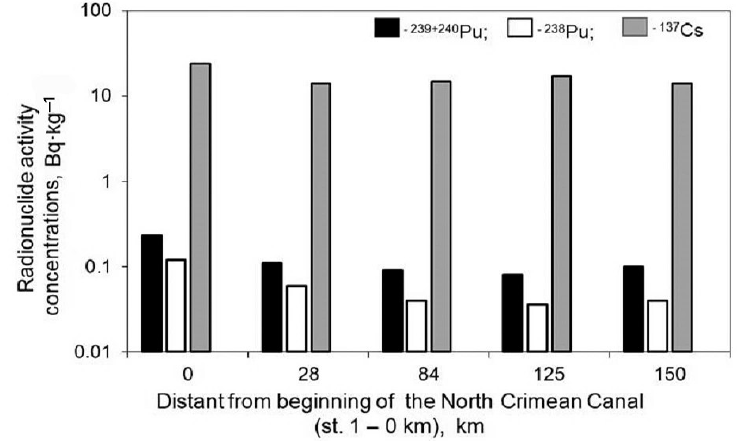
Figure 12. Change in the activity concentration of radionuclides in the bottom sediments (d.w.) of the NCC with increasing distance from the beginning of the NCC.